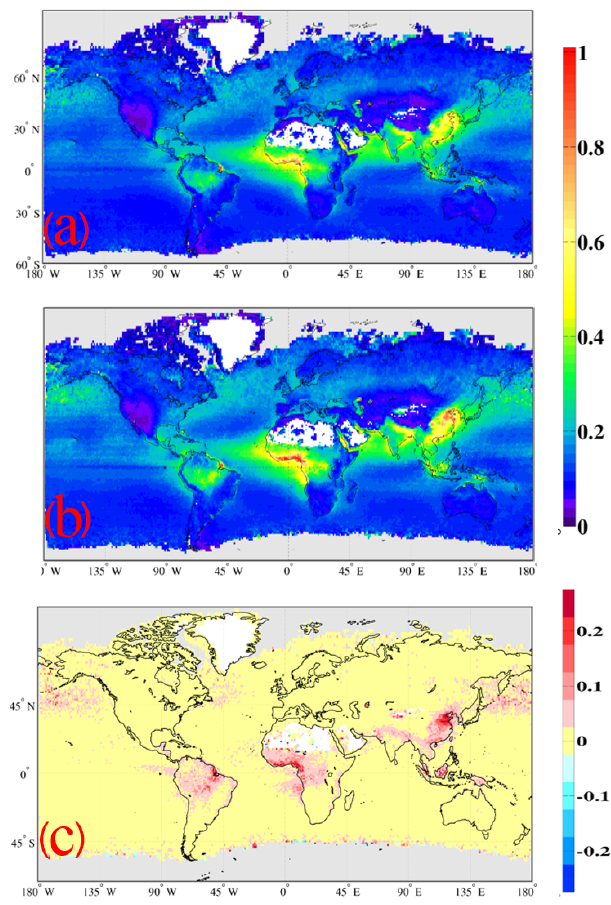
Figure 10. Global aggregated AOD retrieved with ADV/ASV for the period 2003–2011 after application of the ExCPP (a) or the Im- CPP (b) and difference in AOD ( c , AOD(ImCPP)-AOD(ExCPP)), as a result of the application of the ExCPP and ImCPP